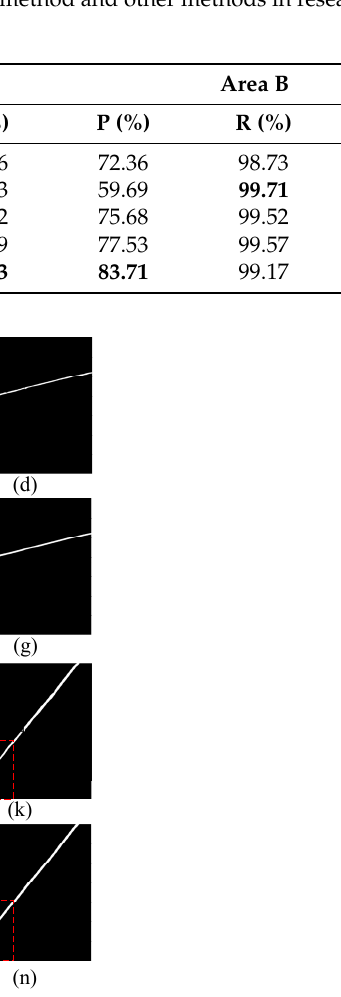
Figure 7. A comparison of classification results in study areas A and B. ( a , h ) Input images; ( b , i ) ground truth; ( c , j ) U-Net; ( d , k ) PSPNet; ( e , l ) RSANet; ( f , m ) D-Linknet; and ( g , n ) GMR-Net. The position of the red-dashed frame indicates the area where the judgment is missing. Table 5. A results comparison between the GMR-Net method and other methods in research areas A and B. The values shown in bold are the best.